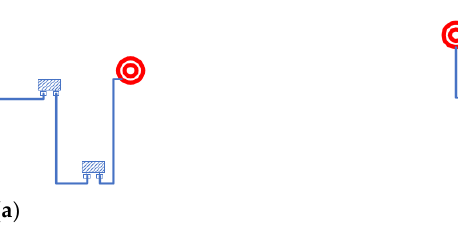
Figure 1. Two different connection mode forms of the same line: ( a ) connection order 1; ( b ) connection order 2.